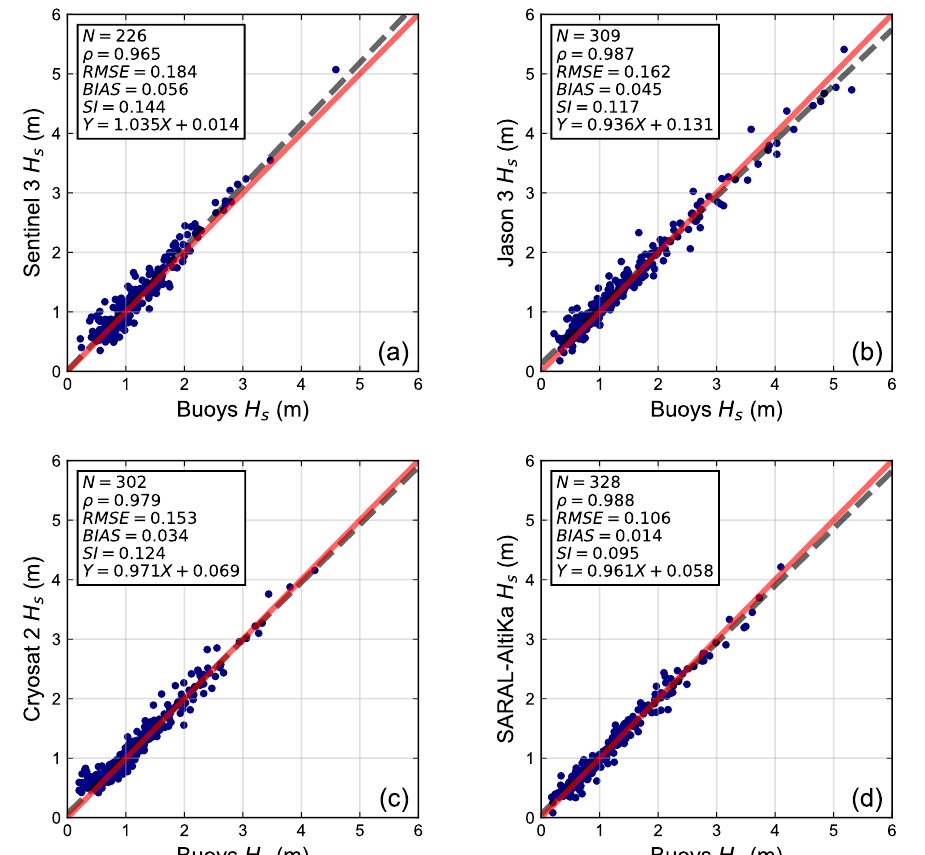
Figure 4. SWH validation of ( a ) Sentinel 3, ( b ) Jason 3, ( c ) Cryosat 2 and ( d ) SARAL-AltiKa against observations from the buoys in the Northeast. N is the collocated dataset sample size and ρ is Pearson’s correlation coefficient. The dashed grey line represents the theoretical Y = X line assuming the two types of measurements are identical. The red line represents the OLS linear regression fit using X and Y to represent the collocated buoy and altimeter